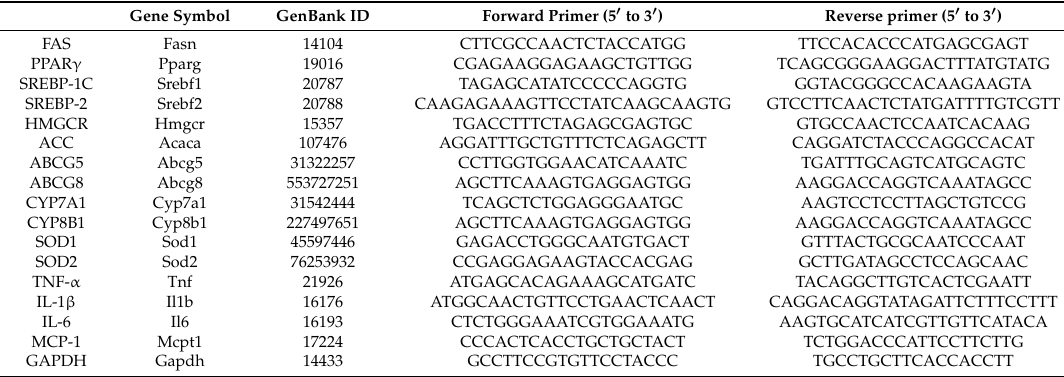
Table 2. The sequences of experimental primers used for RT-PCR. Gene Symbol GenBank